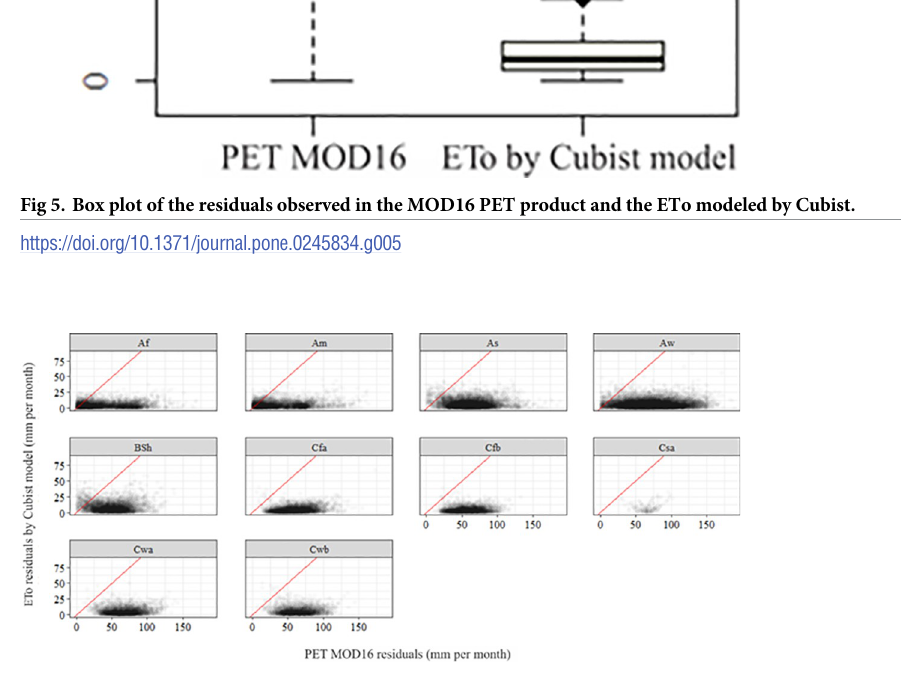
Fig 6. Residual of MOD16 PET x residual of ETo (Cubist model) according to Ko¨ppen’s classification. The figure was elaborated using the R software, according to the Ko¨ppen climate classification for each season.